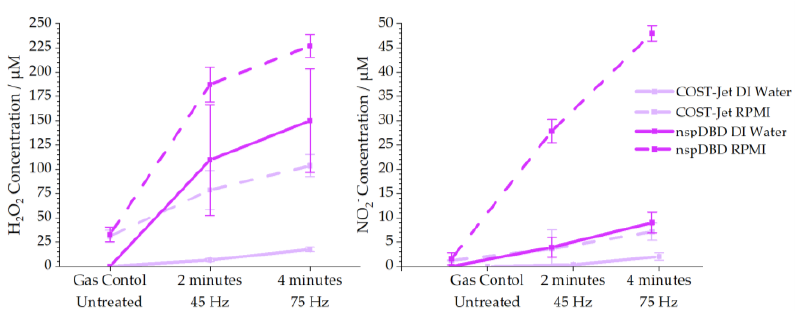
Figure5. ConcentrationsofH 2 O 2 ( Left )andNO 2 − ( Right )inDIwater(solidline)orRPMI(RoswellPark Figure 5. Concentrations of H 2 O 2 ( Left ) and NO 2 − ( Right ) in DI water (solid line) or RPMI (Roswell Park Memorial Institute) supplemented with 10% fetal bovine serum (FBS) and 1% Memorial Institute) supplemented with 10% fetal bovine serum (FBS) and 1% penicillin / streptomycin penicillin/streptomycin (P/S) (dashed line) post plasma treatment. The gas control and untreated H 2 O 2 (P / S) (dashed line) post plasma treatment. The gas control and untreated H 2 O 2 measurement indicate measurement indicate the medium itself is detected by the peroxide kit used. These experiments were the medium itself is detected by the peroxide kit used. These experiments were repeated once, and the repeated once, and the data plotted represent the mean and standard deviation. data plotted represent the mean and standard